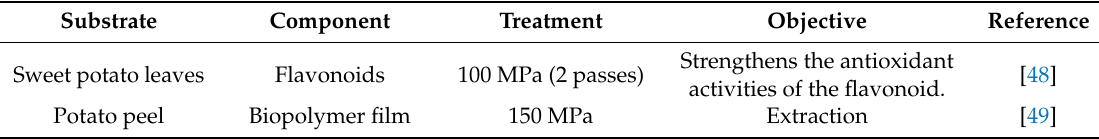
Table 3. Research works aimed to the extraction and improvement of technological functionality of proteins, fibers or bioactive compounds from agri-food wastes by